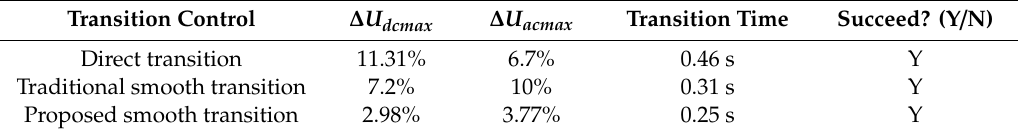
Figure 12. DC voltage, AC voltage, and frequency with islanding signal-based smooth transition control. Table 1. Hybrid micro-grid operating status, from grid-connected mode to islanding mode.